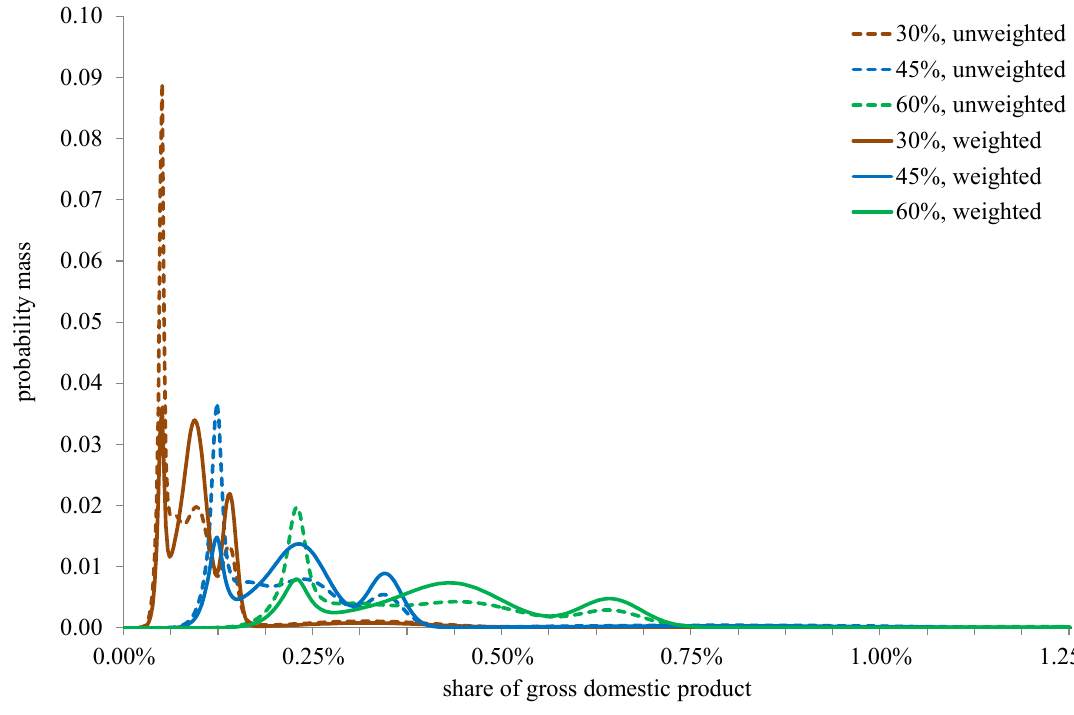
Figure 5. The probability density functions of the total costs, weighted and unweighted, of a 30%, 40% and 50% emission reduction (from base year) in